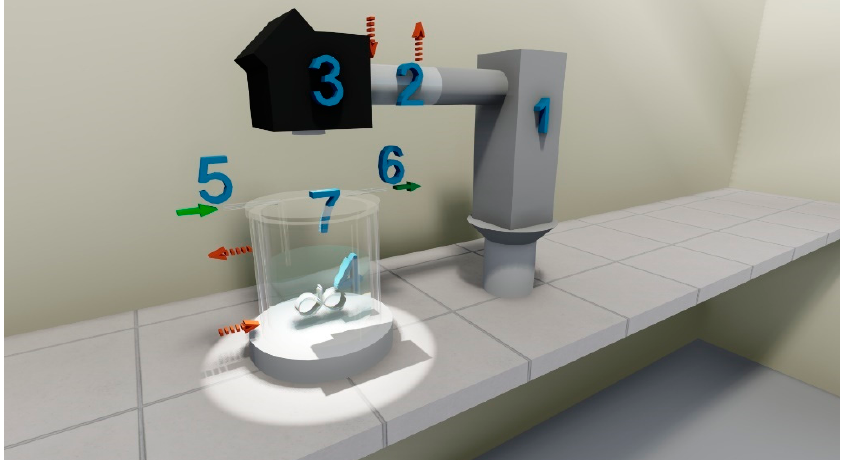
Figure 3. Experimental reactor utilized in the experiments. Elements: (1) Hg lamp, (2) water filter, (3) dichroic filter (280–400 nm), (4) methanol–water/catalyst suspension, (5) argon carrier inlet, (6) argon carrier and gas products outlet, and (7) neutral filter. Red dotted arrows indicate inlet and outlet cooling water.